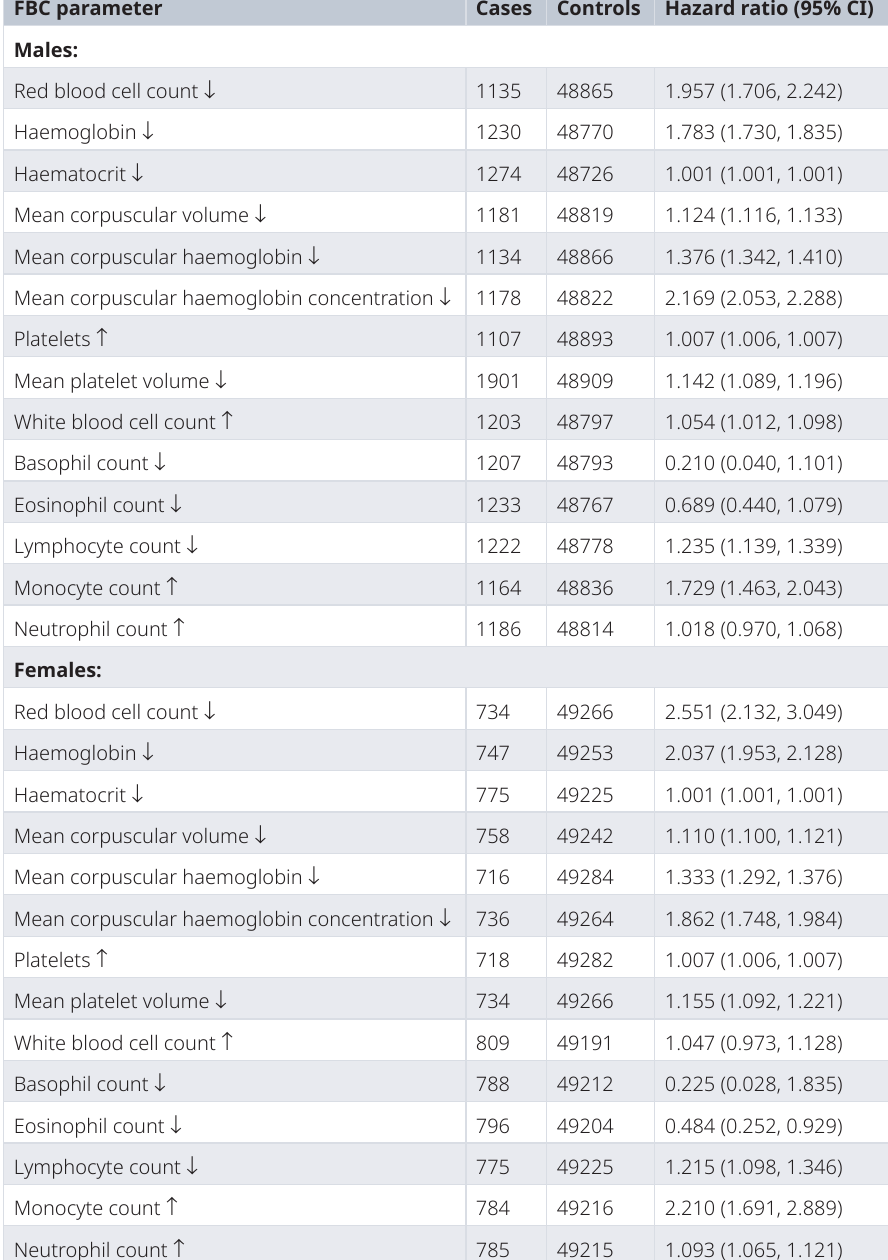
Table 11. Hazard ratios of age-adjusted FBC trends from univariate joint